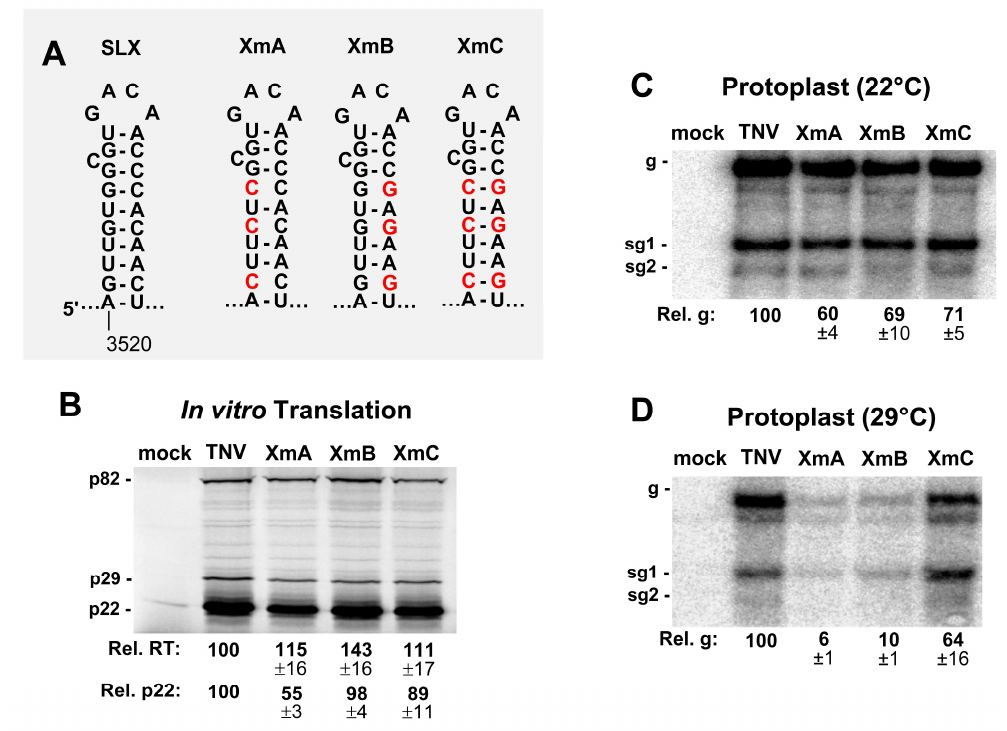
Figure 5. Mutational analysis of the stem of SLX. ( A ) Wild-type and mutant SLXs, with substituted nucleotides in red. ( B ) In vitro translation analysis of the SLX mutants. ( C and D ) Northern blot analysis of the protoplast infections with SLX mutants at ( C ) 22 ◦ C and ( D ) 29 ◦ C.